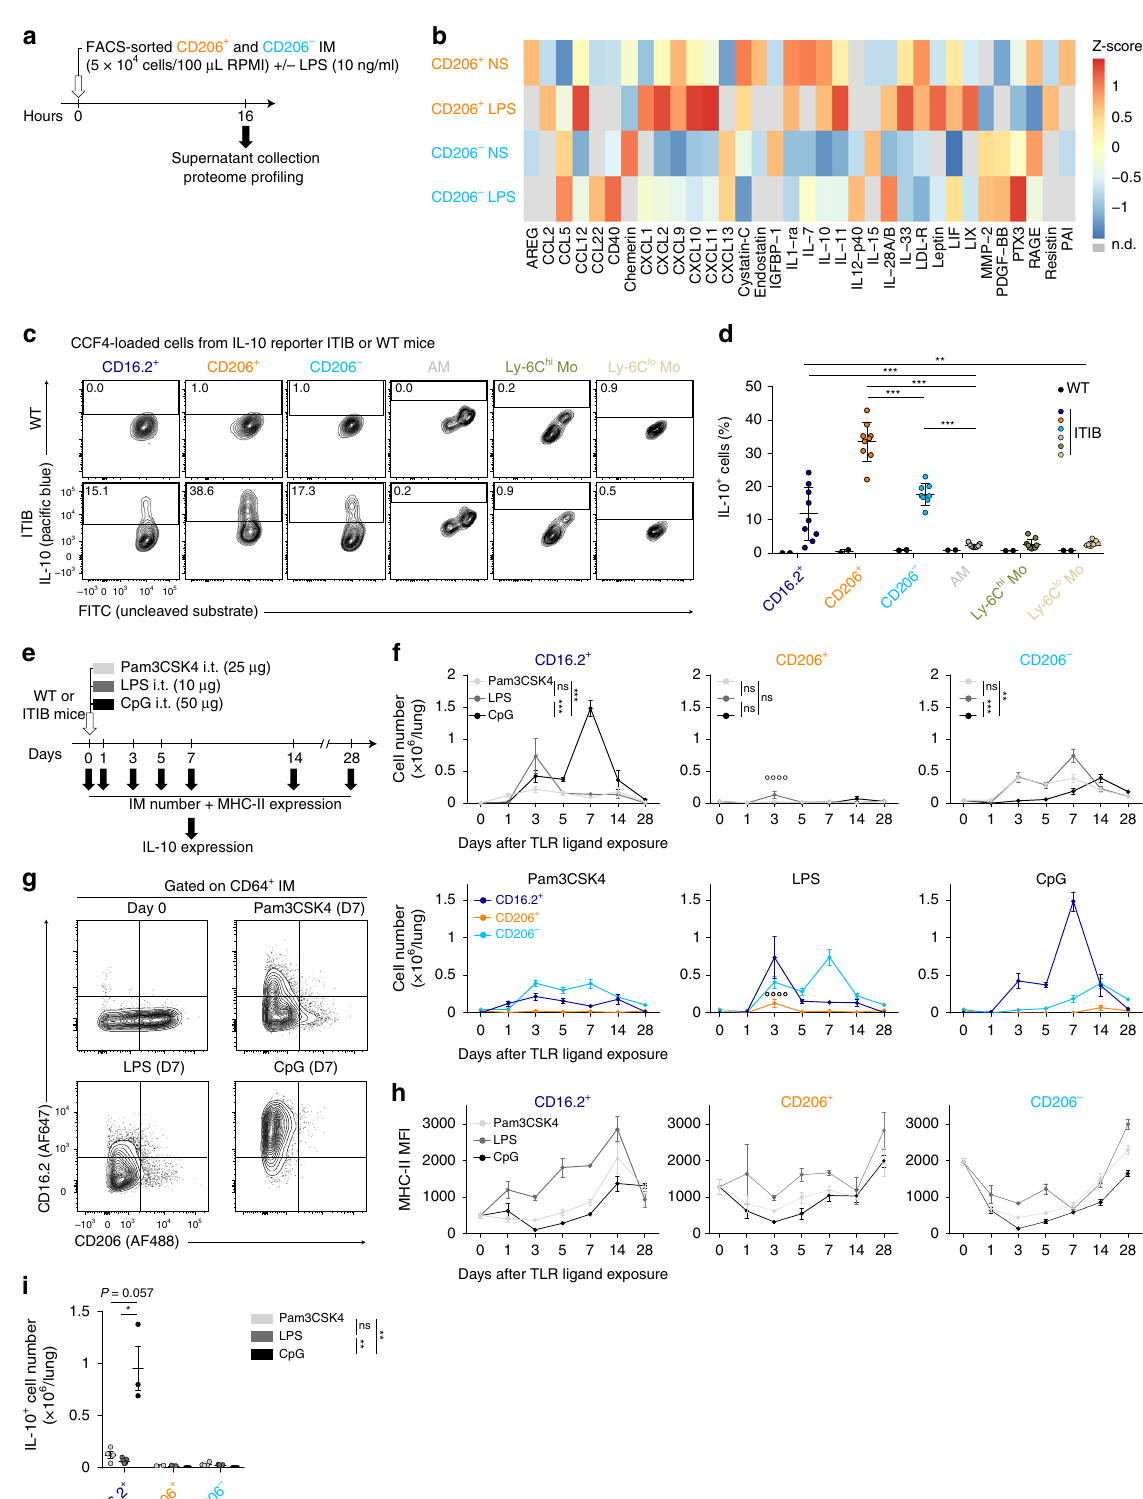
were repopulated by CCR2-dependent classical monocytes after lethal irradiation (Fig. 7b) 18 . Nevertheless, there was a signi fi cant enrichment, in repopulated CD64 + CD16.2 + monocytes, in cells of CD45.1 + WT origin as compared to NR4A1-independent cells (Fig. 7b), supporting the idea that even in such extreme conditions, Ly-6C lo patrolling monocytes substantially contributed to the